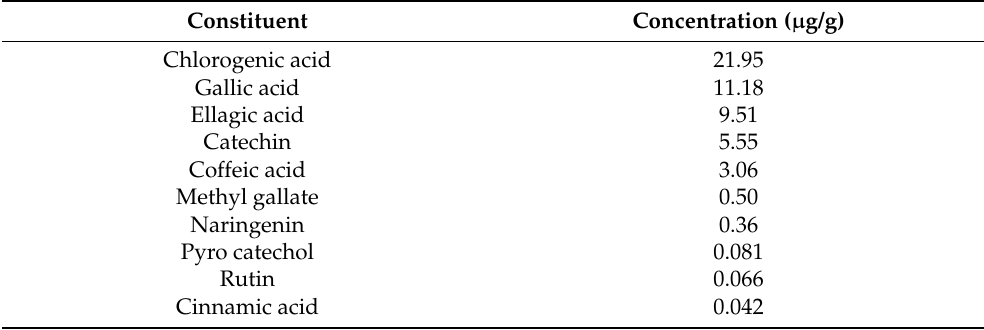
Table 1. Composition of pomegranate extract (PGE)obtained by high-performance liquid chromatog- raphy